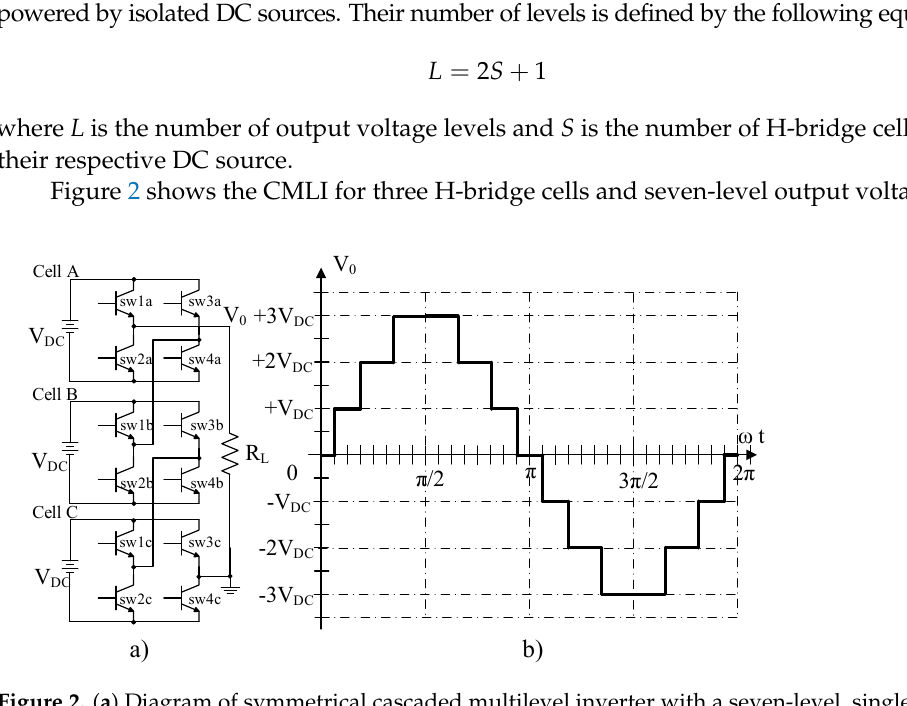
Figure 2. ( a ) Diagram of symmetrical cascaded multilevel inverter with a seven-level, single-phase structure. ( b ) Output voltage waveform.